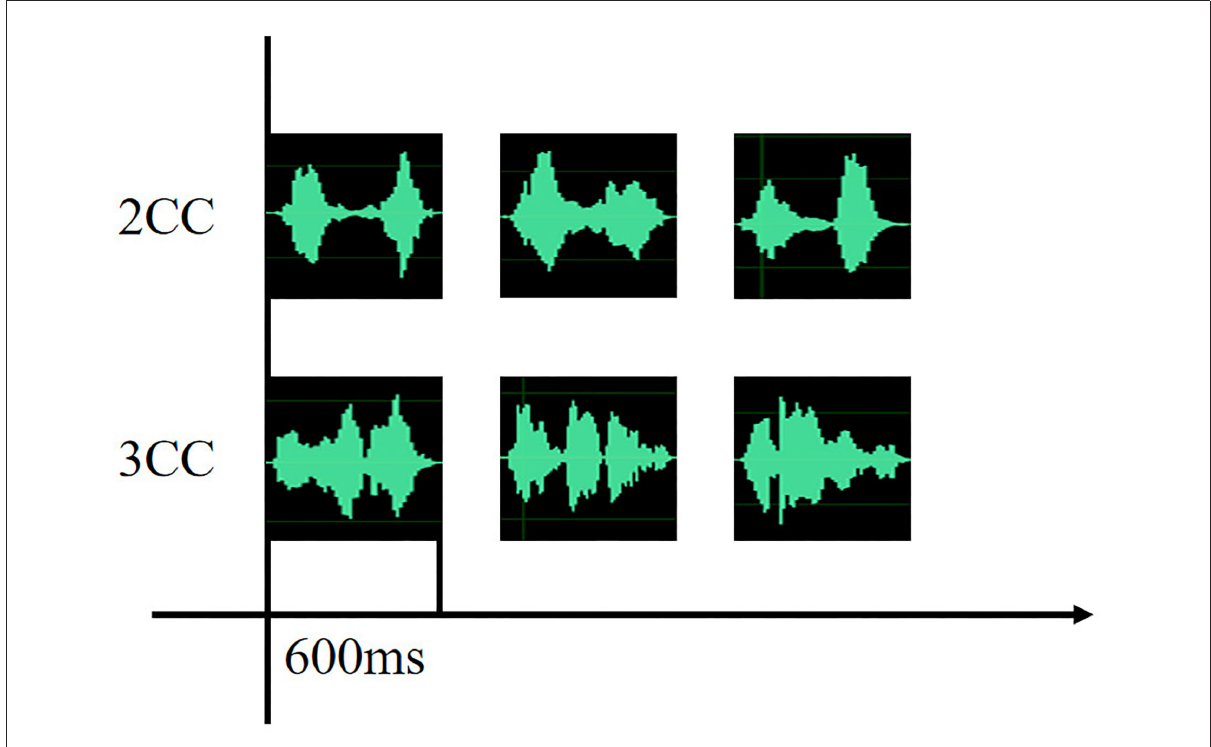
FIGURE1 Sound signal waveforms of 2CC and 3CC.